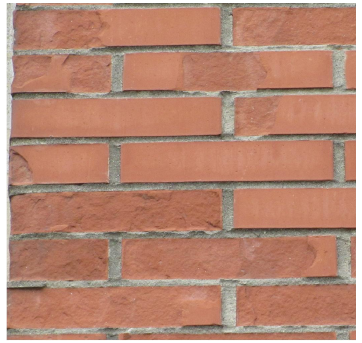
Figure 2. Close view of bricks on the